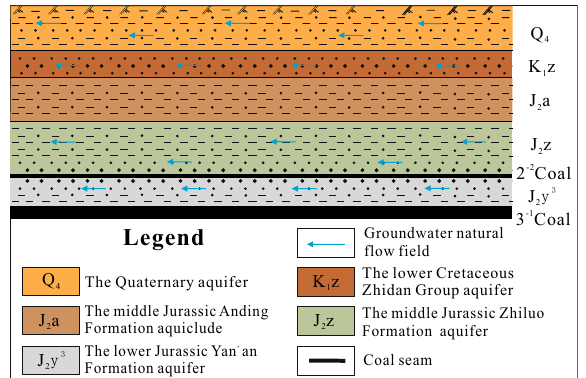
Figure 2. Hydrogeological section of the study